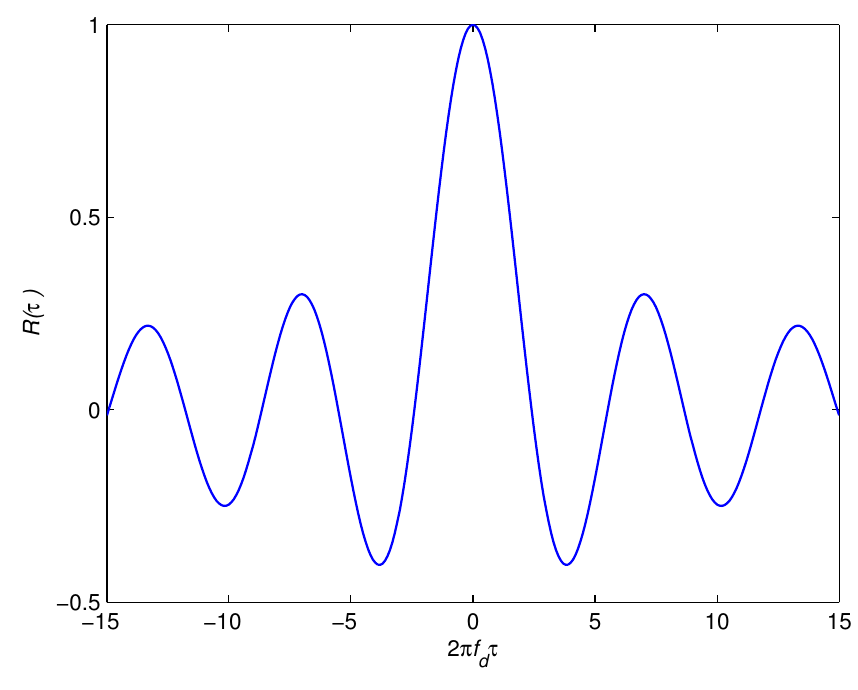
Figure 1. Auto-correlation function of the fading